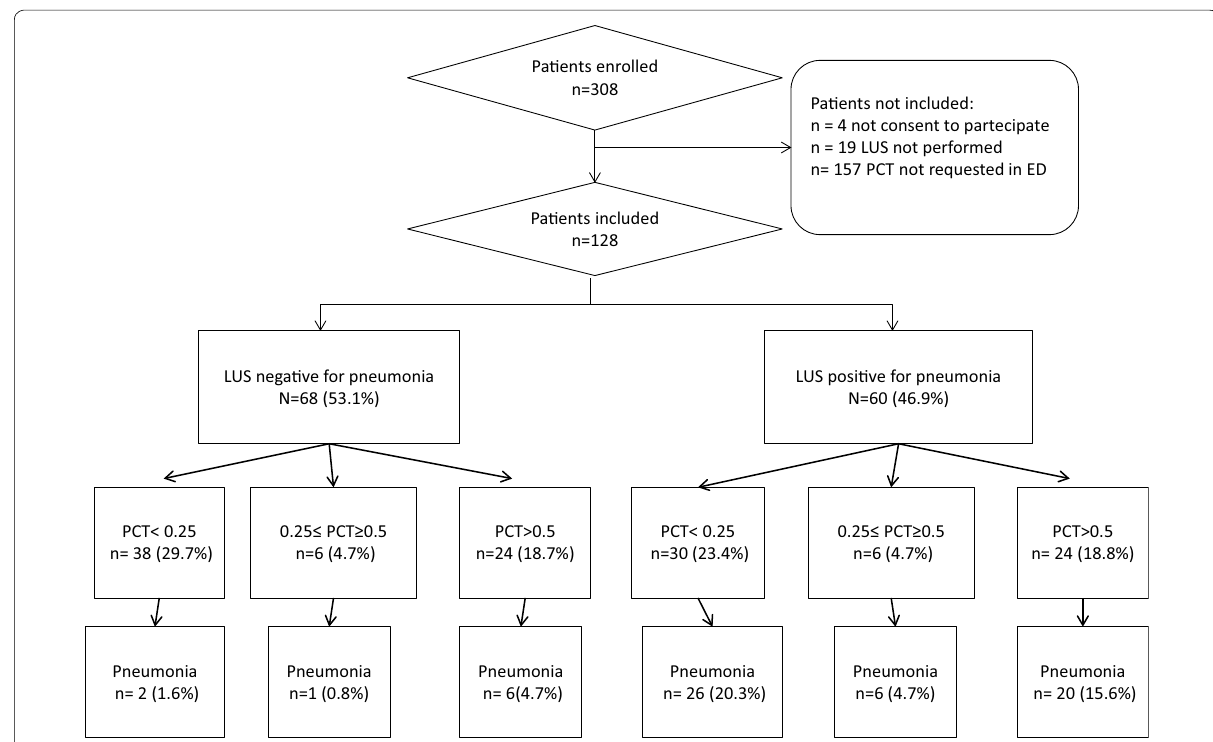
Fig. 1 Characteristics of patients according to the presence or absence of pneumonia. LUS lung ultrasonography; PCT procalcitonin